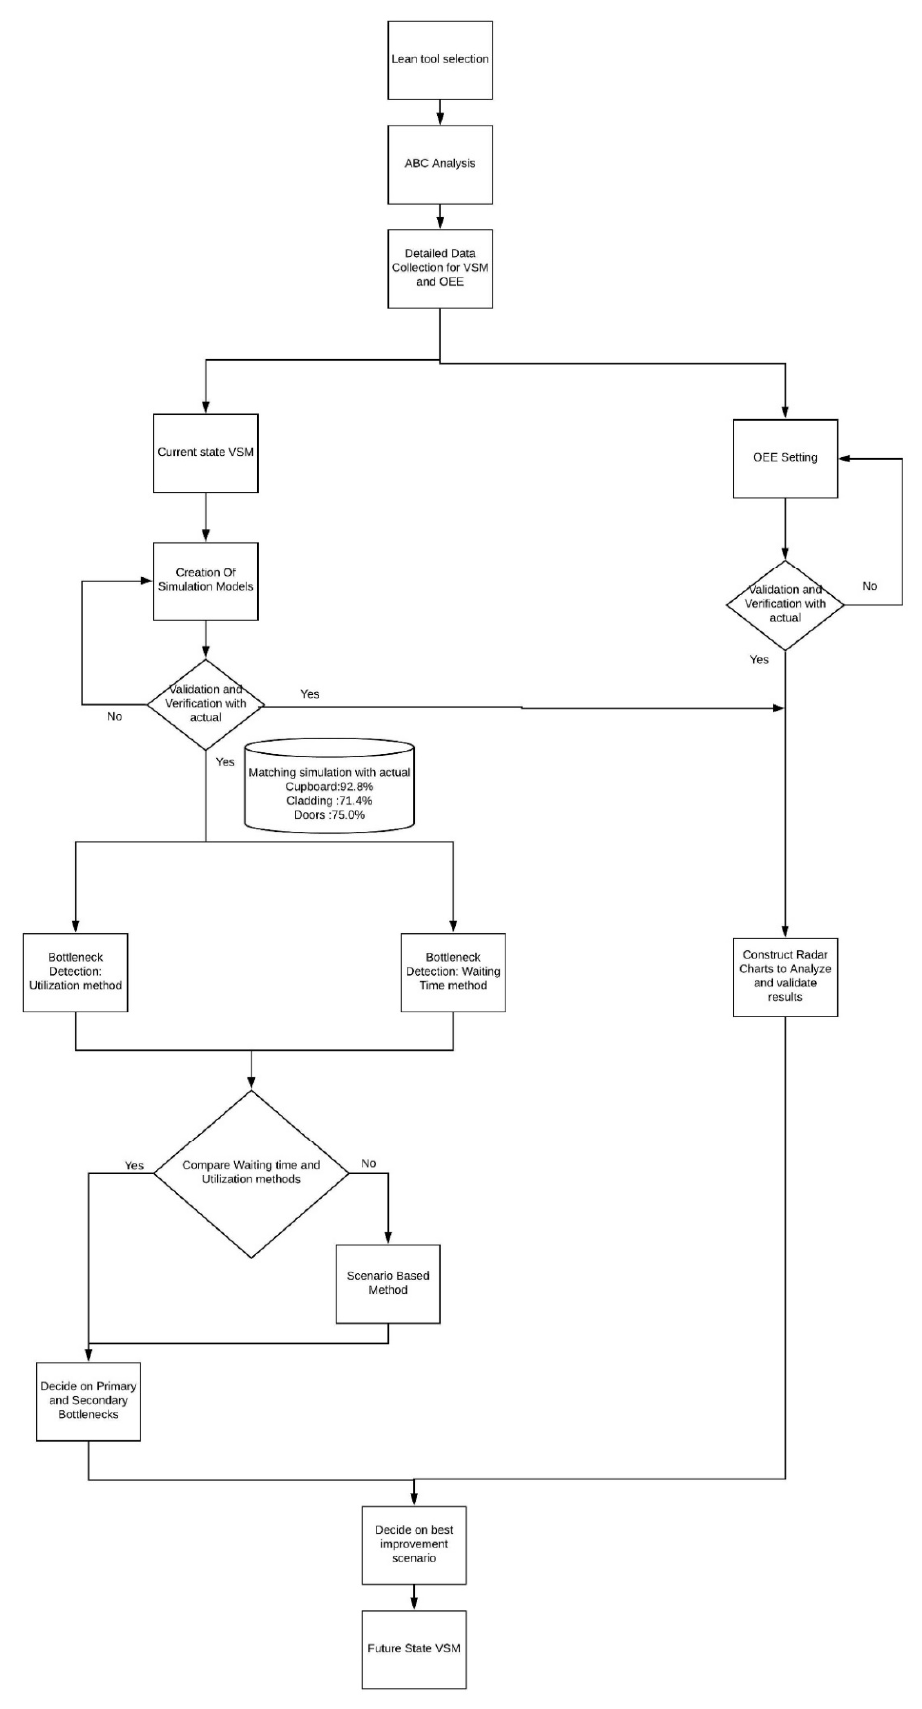
Figure 1. Problem-solving approach.